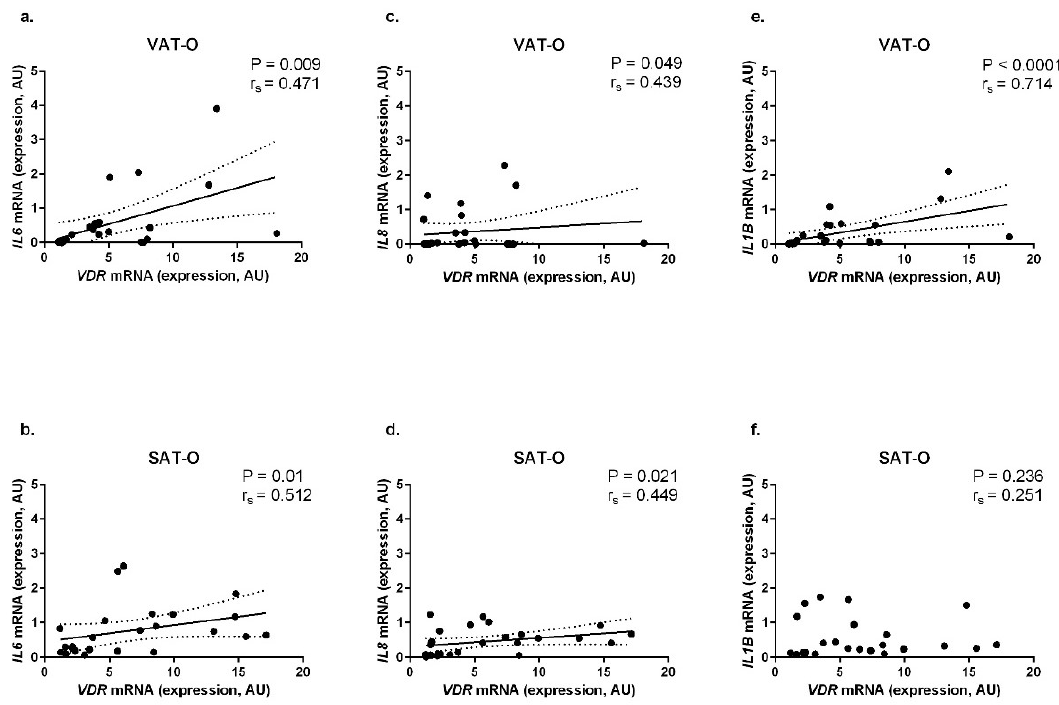
Figure 4. Correlation between mRNA levels of VDR and mRNA levels of genes encoding interleukin 6 ( IL6 a , b ), interleukin 8 ( IL8 c , d ) and interleukin 1β ( IL1B e , f ) in visceral (VAT) and subcutaneous (SAT) adipose tissue of obese (O) individuals.